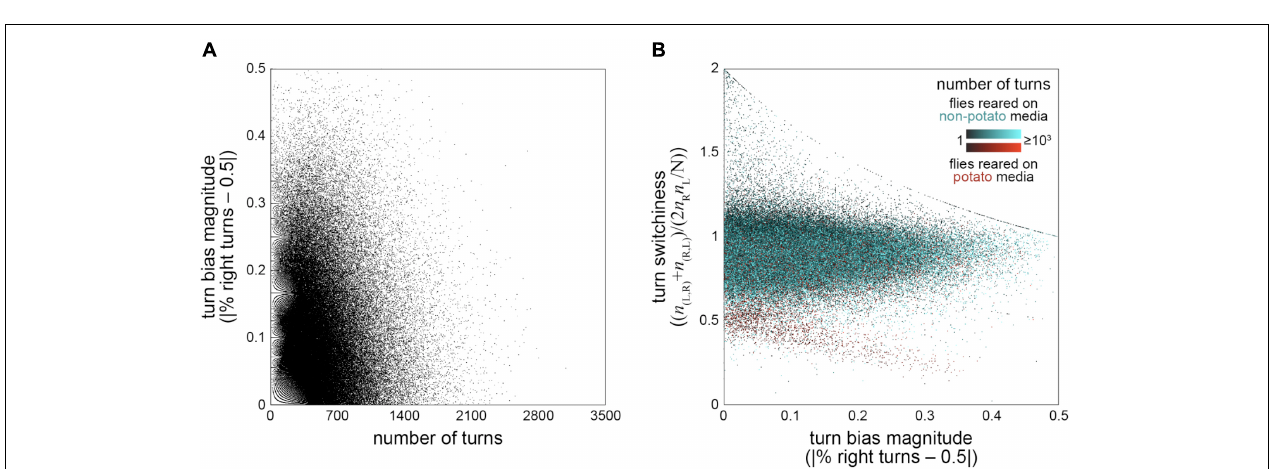
FIGURE 4 | Correlations between behavior measures— (A) Turn bias magnitude vs. number of turns. Each point is a fly ( n = 183,496). Fractal-like pattern at left is a consequence of the limited turn bias values that are possible for a given discrete number of turns. r = 0.0357, p < 10 − 50 . (B) Turn switchiness vs. turn bias magnitude. Each point is a fly and colored on a scale depending on whether the flies were reared on cornmeal-dextrose agar media (black-cyan; n = 157,321) or F4-24 potato flake media (black-red; n = 26,175). Point color value indicates sample size, with dark flies making fewer turns. Curvilinear features are a consequence of limited switchiness values possible for a given turn bias magnitude, a constraint that arises most obviously in flies making fewer turns (dark